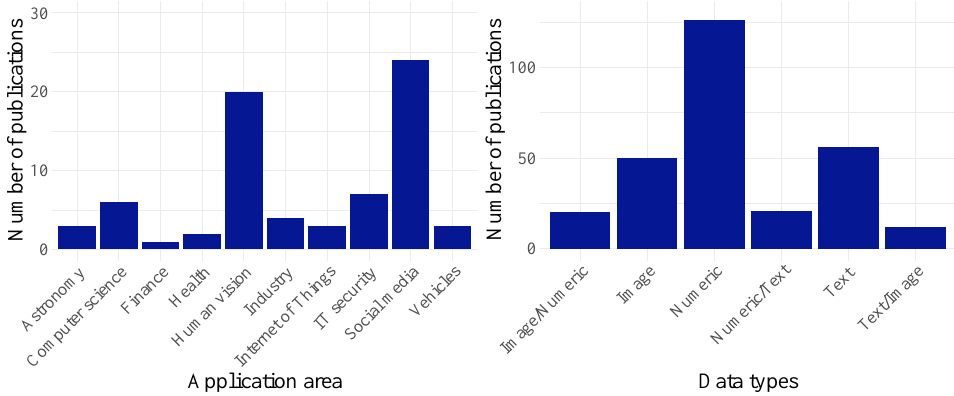
Figure 3. Distribution of outlet disciplines and data types in our literature